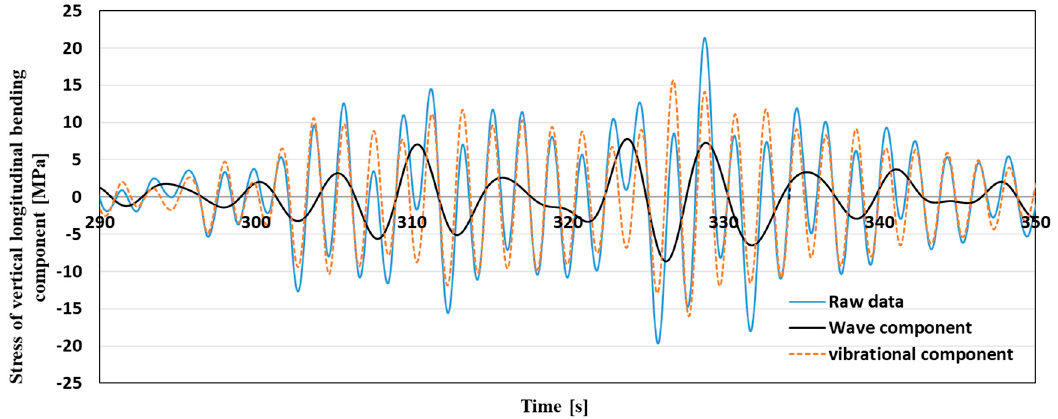
Figure 11. Time-series stress data during 290–350 s of the vertical longitudinal bending component.